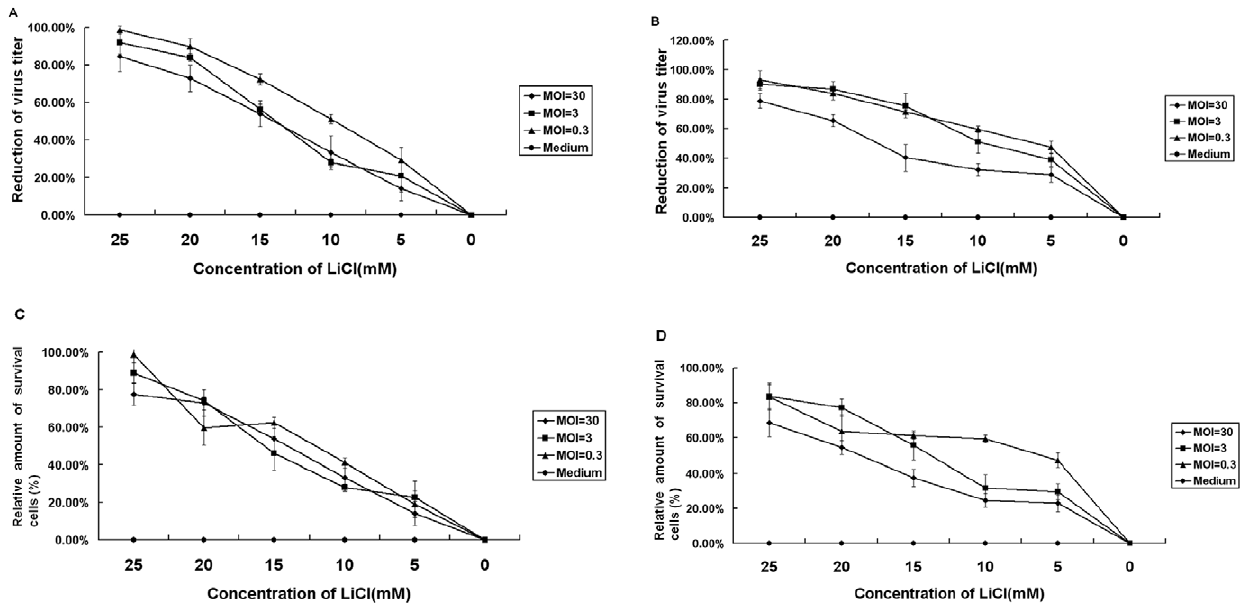
Figure 2. Protective effect of LiCl on TGEV infection of cultured cells. Increasing concentrations of LiCl were added to cells in 24-well plates infected with TGEV at different MOI at 1 hpi. At 48 hpi, the yield of virus in the supernatant was determined by plaque assays. The inhibition rates calculated from drug-treated ST and PK cells determined by plaque assays are shown in panels A and B, respectively. The effect of the infection was also determined by MTT assays. The relative amount of survival cells were calculated as described in M&M. The result obtained with ST and PK cells is shown in Panels C and D, respectively.